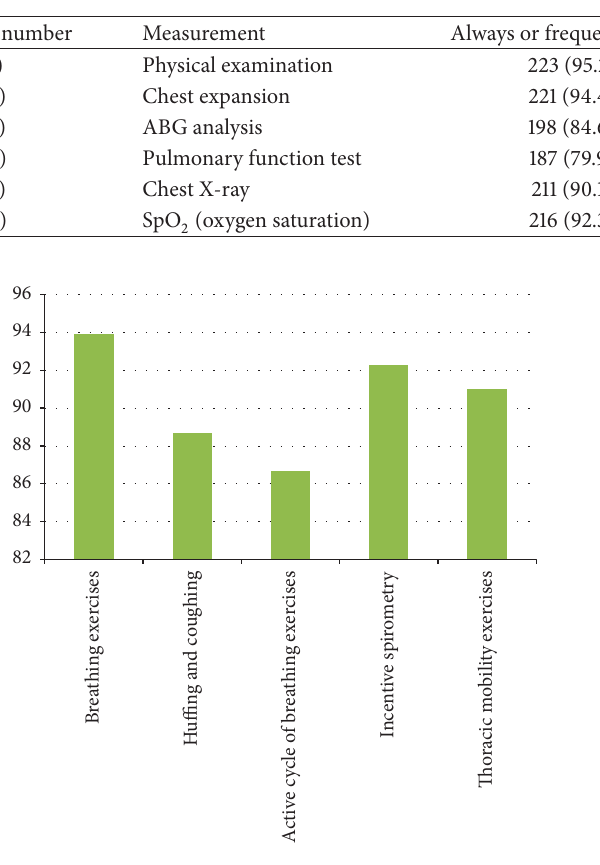
Figure 3: Preoperative physiotherapy interventions for thoracic surgery patients.